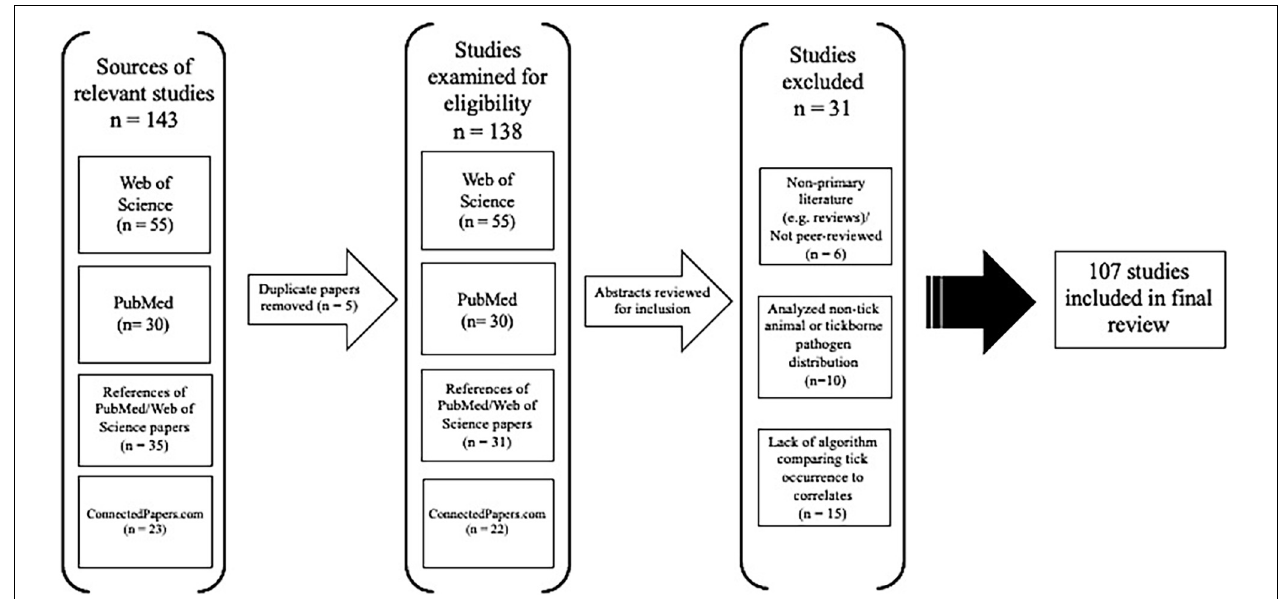
FIGURE 1 | Flow chart of tick species distribution model (SDM) article inclusion and exclusion based on PRISMA criteria.